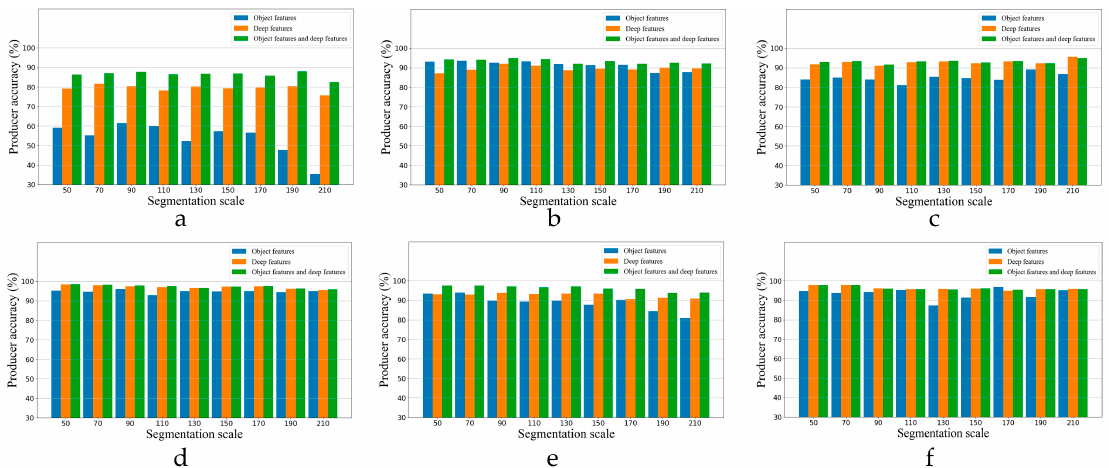
Figure 20. Producer accuracies of Buildings ( a ), Vegetation ( b ), Roads ( c ), Water ( d ), Shadows ( e ) and Bare soils ( f ) with different feature combinations.